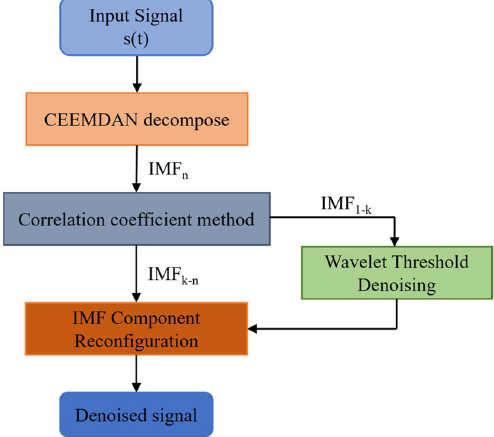
Figure 1. CEEMDAN operating